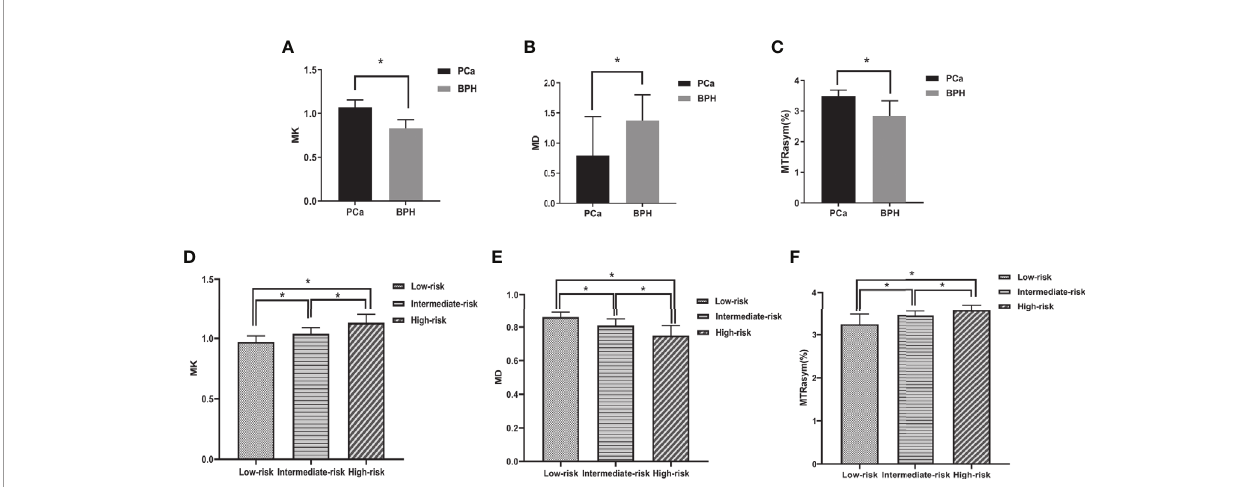
FIGURE 4 | Boxplots of MK/MD/MTRasym (3.5 ppm) values in different groups. (A – C) show the comparison of parameters between BPH and PCa, respectively. (D – F) show the comparison of parameters between low-, intermediate-, high-risk groups, respectively. * represents P <